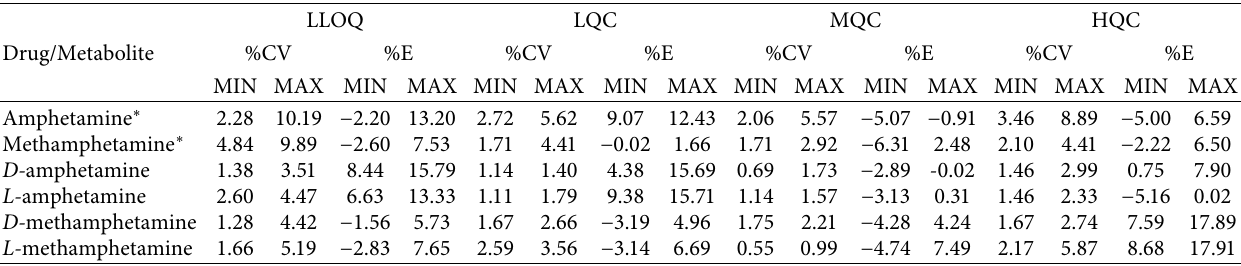
Table 6: Intraassay precision and accuracy: precision and accuracy over 3 days with replicates of 6 for each day.